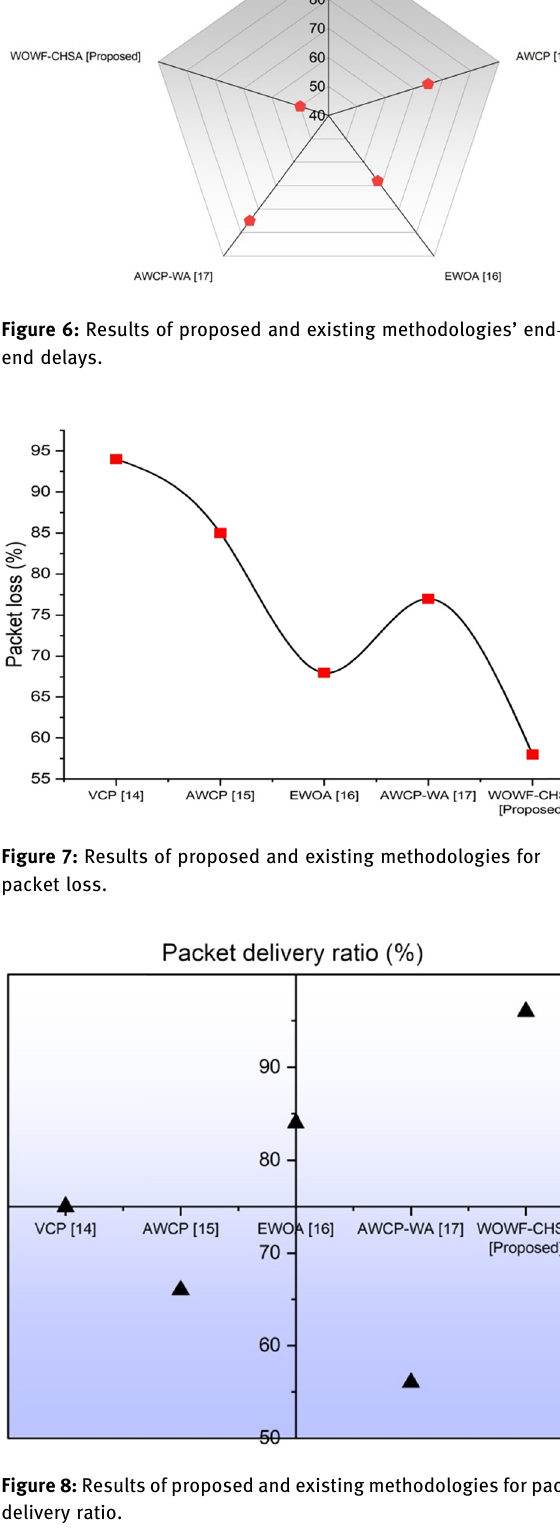
Figure 5: Throughput results of proposed and existing methodology.